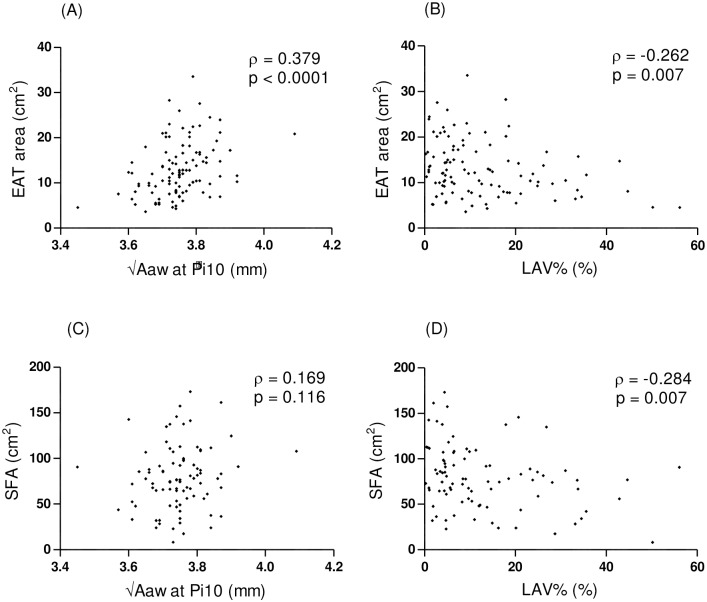
Correlation between adipose tissue and quantitative CT parameters in COPD patients.Spearman’s rank correlation coefficient was used to evaluate these relationships. The EAT area was positively associated with the √Aaw at Pi10 (A) and inversely associated with the LAV% (B). The SFA was inversely associated with the LAV% (D) but not with the √Aaw at Pi10 (C).